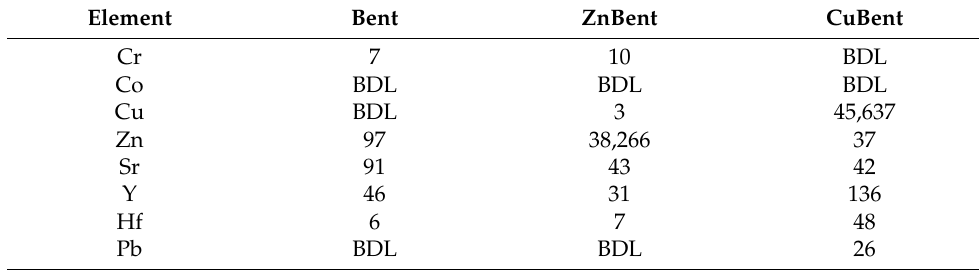
Table 1. Major element composition (% oxides) (XRF) of Bent, ZnBent, and CuBent powder samples.